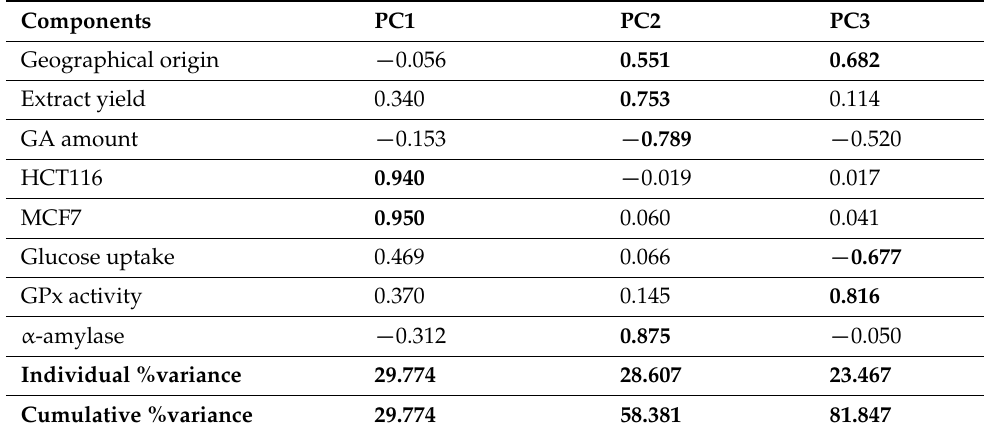
Figure 2. Scree plot for the component analysis of Glycyrrhiza glabra activities. Table 4. The principal component analysis for licorice samples.